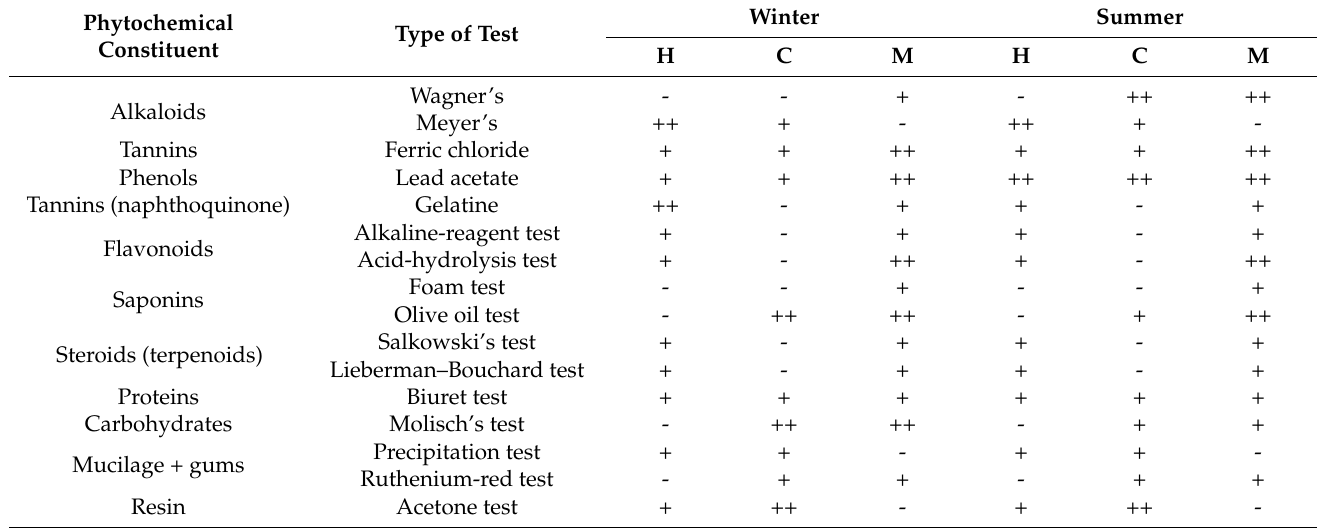
Table 2. Qualitative preliminary screening of phytochemicals of C. macrocarpa leaf extracts for summer and winter